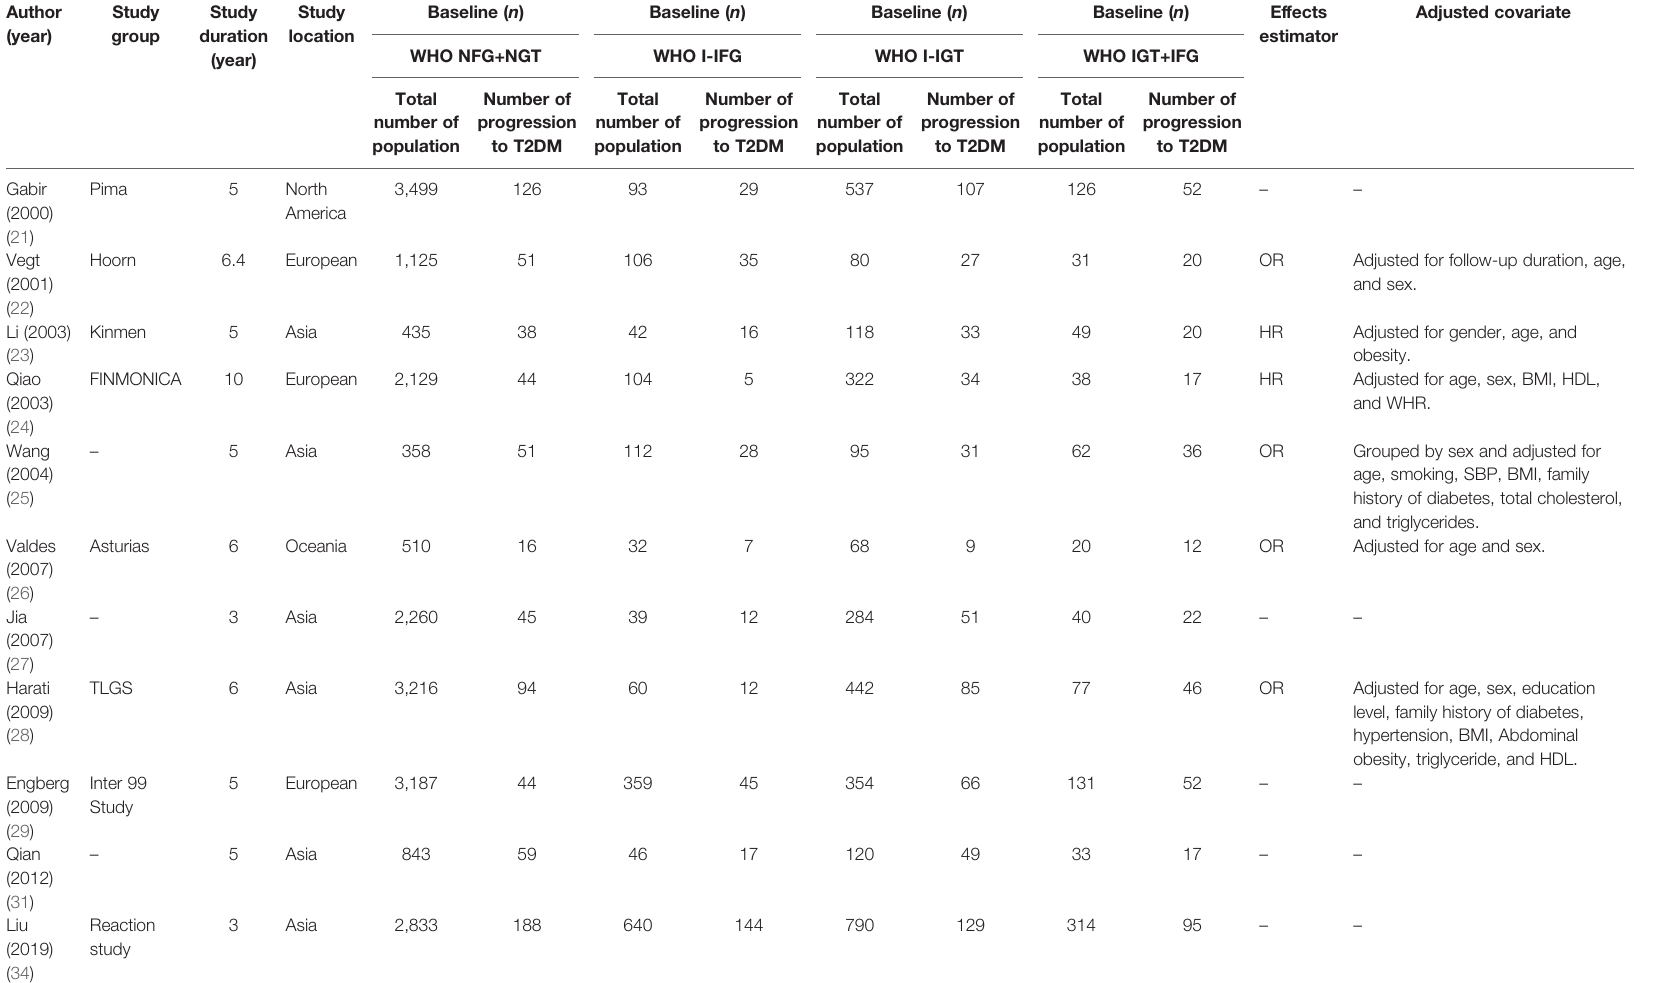
TABLE 1 | Characteristics of the included studies according to the WHO 1999 classi fi cation